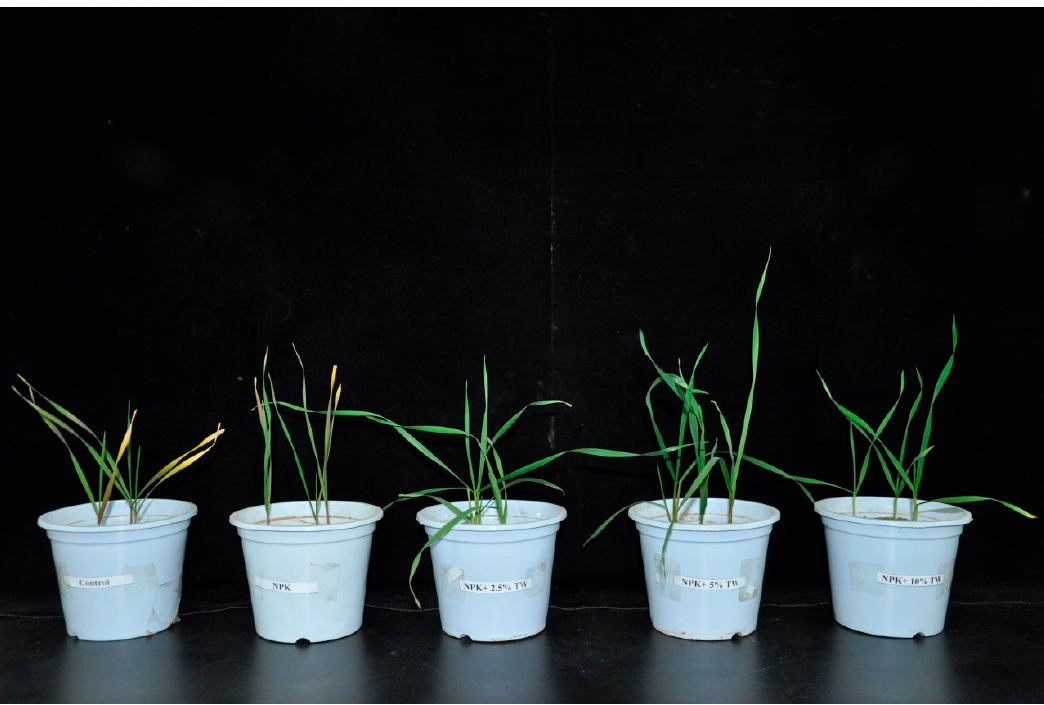
Figure 8. Influences of co-application of TW and chemical fertilizers on physiological parameters of wheat plants after 56 days. T1 (Control without an amendment), T2 (Chemical fertilizers), T3 (F + 2.5% TW), T4 (F + 5% TW), and T5 (F + 10% TW).